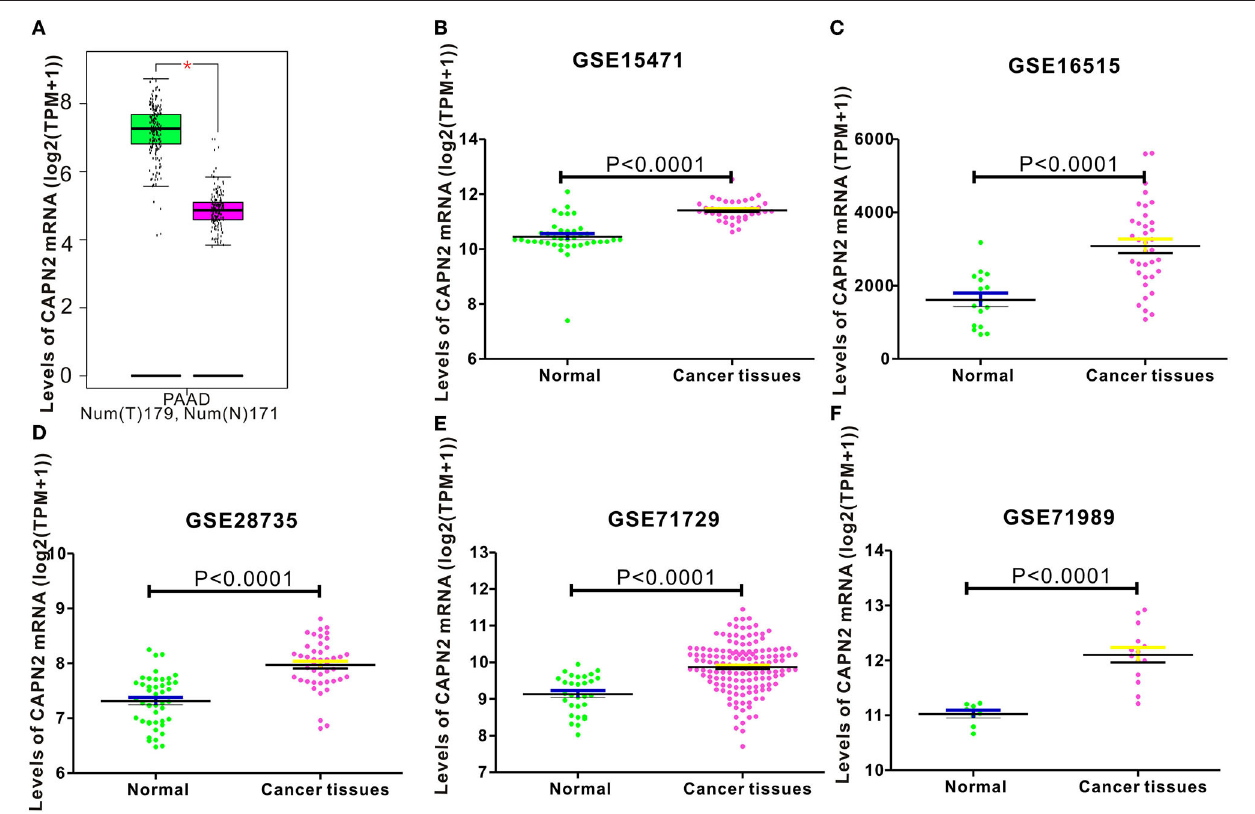
FIGURE 1 | Analysis of CAPN2 mRNA expression in normal and pancreatic cancer (PC) tissues from public databases. CAPN2 mRNA levels were significantly lower ( P < 0.0001) in normal pancreatic tissue than in pancreatic cancer tissue samples in the (A) STAD dataset (Normal = 171; Tumor = 179) from the TCGA database; (B) GSE15471 (Normal = 39; Tumor = 39); (C) GSE16515 (Normal = 16; Tumor = 36); (D) GSE28735 (Normal = 45; Tumor = 45); (E) GSE71729 (Normal = 30; Tumor = 145); (F) GSE71989 (Normal = 8; Tumor = 14) datasets from the GEO